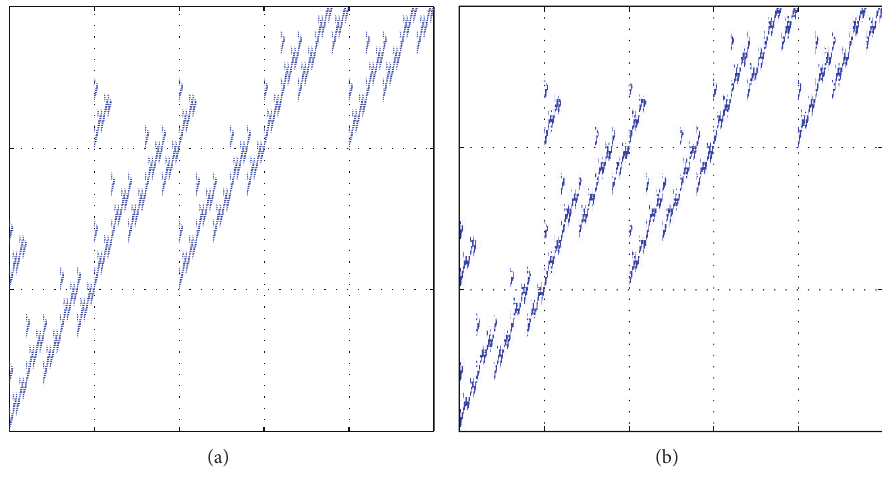
Figure 2: The first and second figures are fourth and seventh steps of iteration,